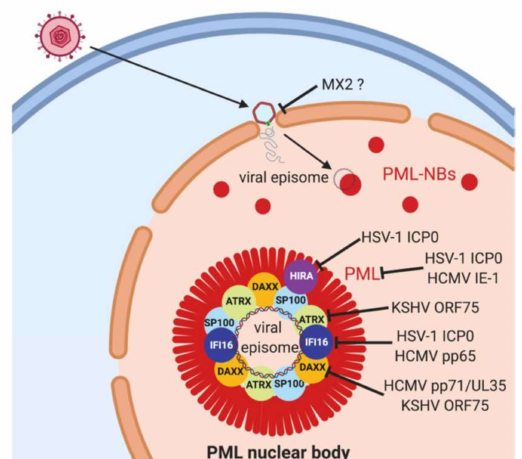
Figure 2. Herpesviral antagonism of PML-nuclear bodies. After the infection of target cells, the herpesviral capsid is transported to the nuclear membrane and the viral DNA released into the nucleus through nuclear pores. The genome rapidly associates with PML nuclear bodies (PML-NBs). PML-NBs are considered as antiviral nuclear organelles that restrict gene expression from viral genomes, and PML-NB components PML, SP100, DAXX and ATRX as well as the transiently associated proteins IFI16 and HIRA have been shown to mediate this restriction. PML is an essential structural component of PML-NBs and depletion of PML disrupts PML-NBs. Herpesviruses in contrast have evolved mechanisms to counteract this restriction, in particular viral tegument and immediate-early proteins as depicted in the graph. ? Indicates hypothetical mode of